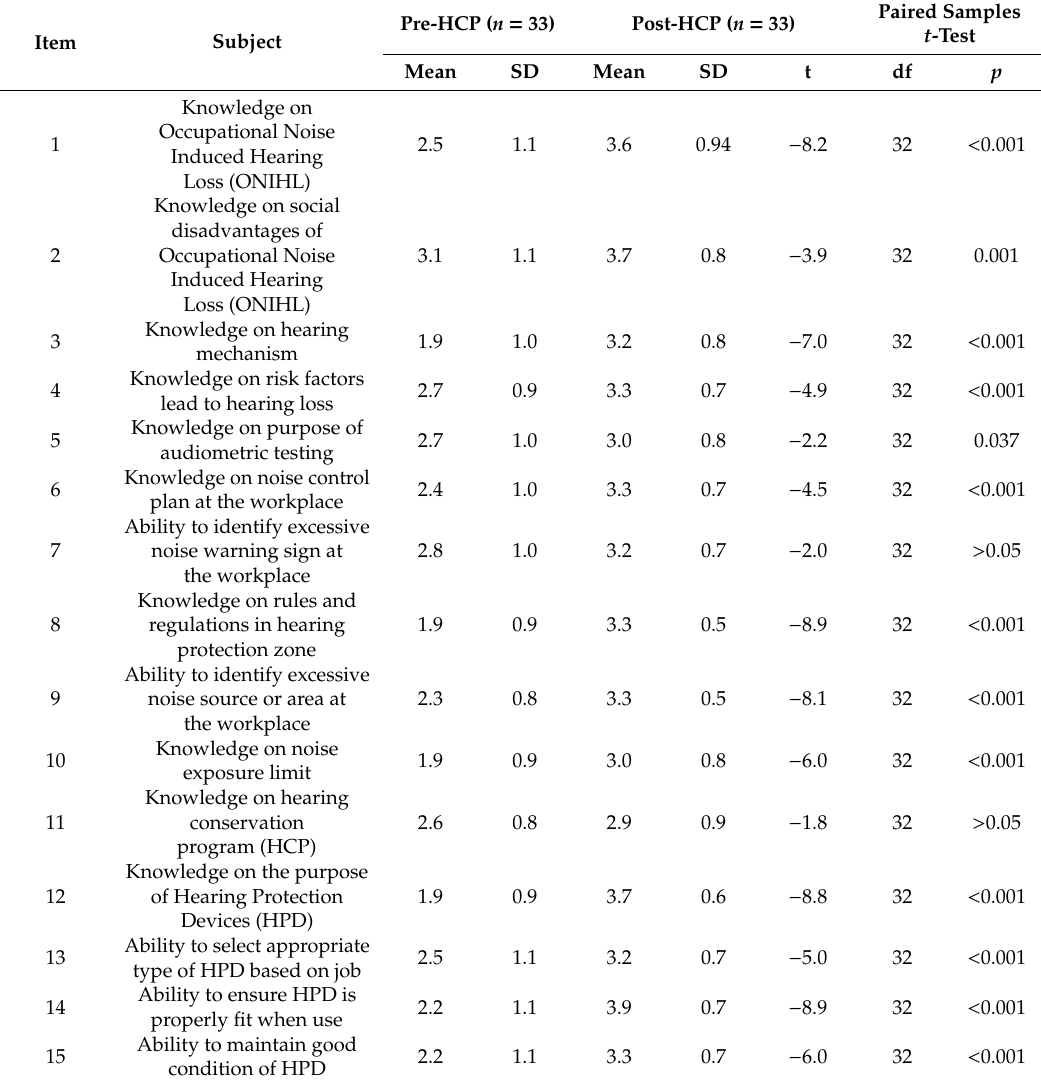
Table 4. Result of participants self-reported knowledge and